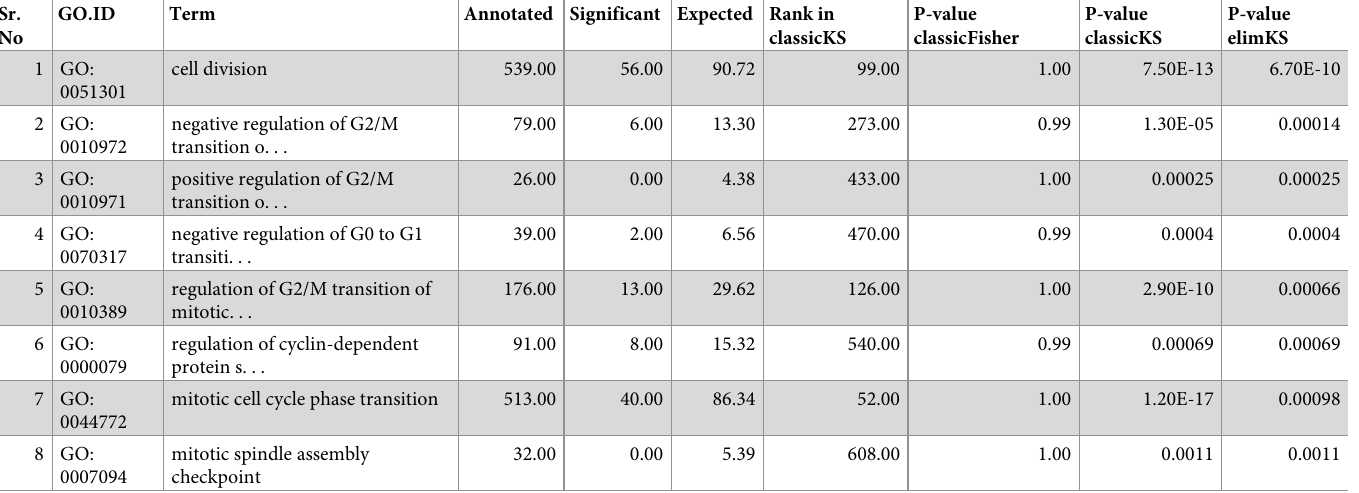
Table 3. Over-represented biological process ontologies of cell cycle/cell division associated with the transcriptome. Sr. No